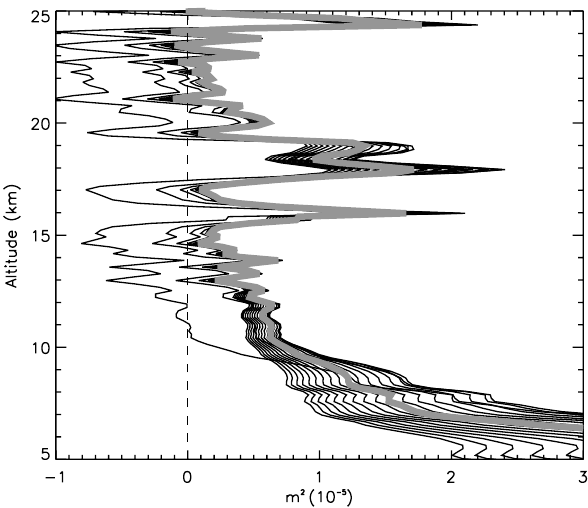
Fig. 4. Altitude profiles of the gravity wave vertical wavenumber- squared (m 2 ) for gravity waves with horizontal wavelengths ranging from 2km to 20km and with an observed period of 90min. The profile at a horizontal wavelength of 10km is shown in grey. The dashed vertical line at m 2 =0 represents the boundary between freely propagating (m 2 > 0) and evanescent/reflected (m 2 < 0) Fig.4. Altitudeprofilesofthegravitywaveverticalwavenumber-squared( m 2 )forgravitywaveswithhorizontalwavelengthsrangingfrom 2-kmto20-kmandwithanobservedperiodof90-min. Theprofileatahorizontalwavelengthof10-kmisshowningrey. Thedashedvertical lineat m 2 =0representstheboundarybetweenfreelypropagating( m 2 > 0)andevanescent/reflected( m 2 < 0)regions.